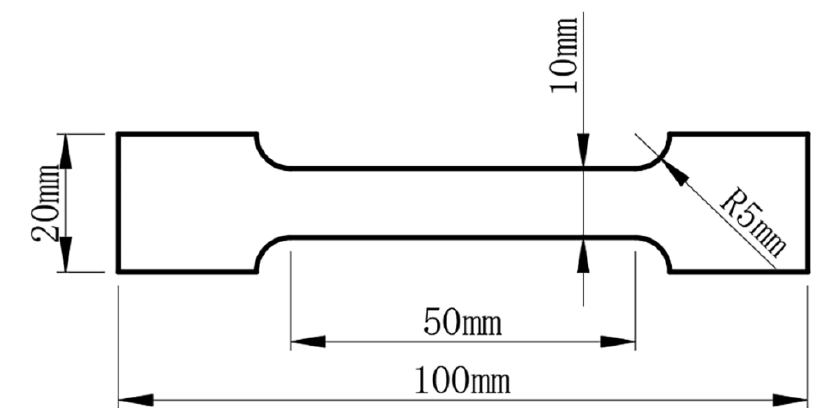
Figure 2. Schematic diagram of tensile specimen size.